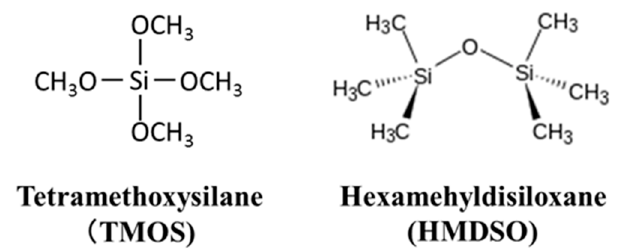
Figure 1. Molecular structures of tetramethoxysilane and hexamethyldisiloxane .